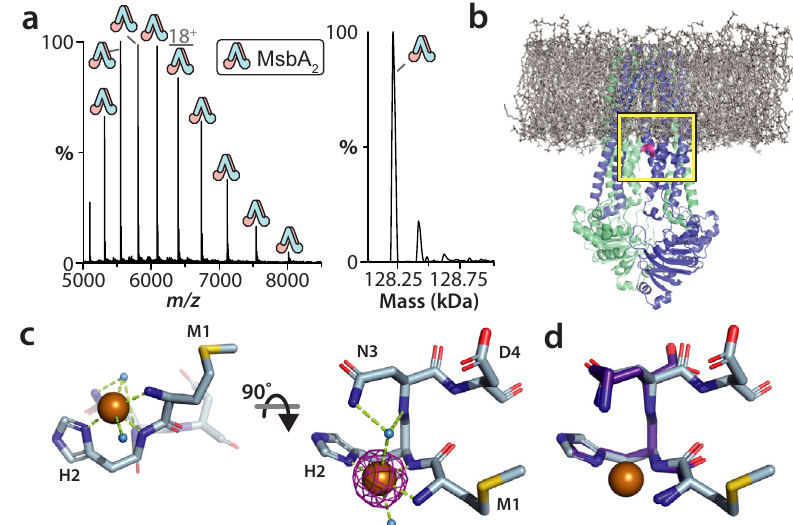
Fig. 2 | The N-terminus of MsbA binds copper(II) and its crystal structure. a Native mass spectrum and deconvolution of MsbA with deletion of four N-terminal residues. No copper(II) is bound to the truncated transporter. b Snapshot from a molecular dynamics simulation of MsbA in a 16:0 PC (DPPC) bilayer (PDB 6BPP downloaded from MemProtMD 44 ). DPPC is shown in stick representation(grey).Proteinisshownincartoonrepresentationwithresidues4-8 colored pink. Yellow box highlights the location of the N-terminus relative to the